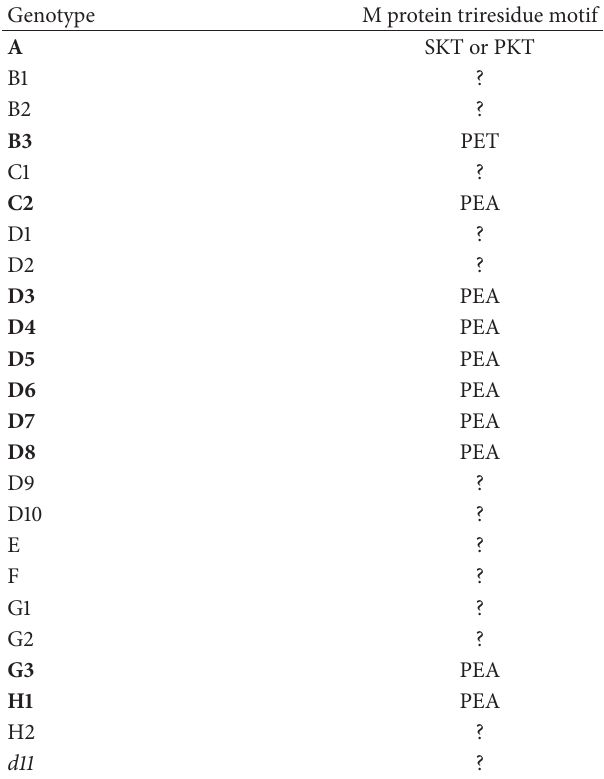
Table 1: Nature of the triresidue motif found in the gene encoding the matrix protein in the different wt MeV